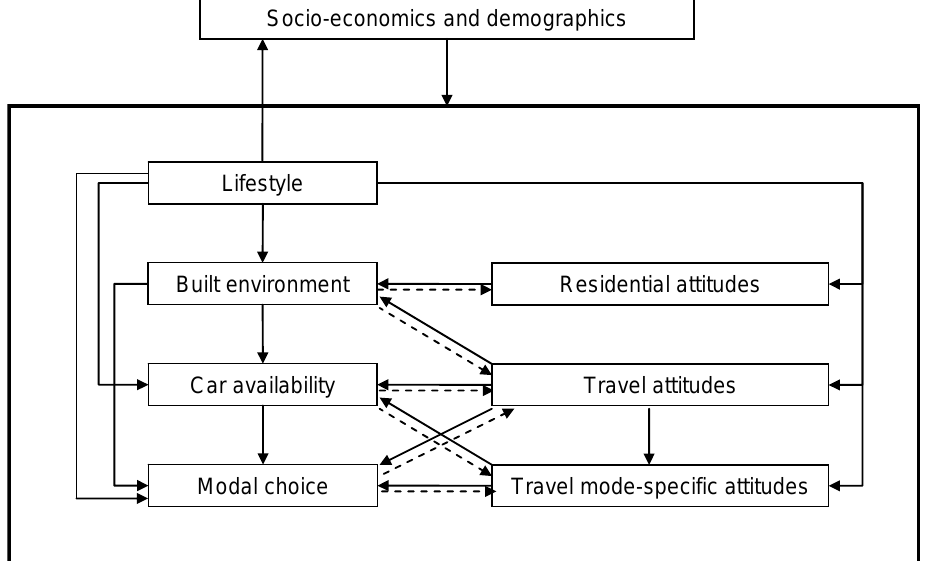
Figure 1. Complex relationships between the built environment and modal